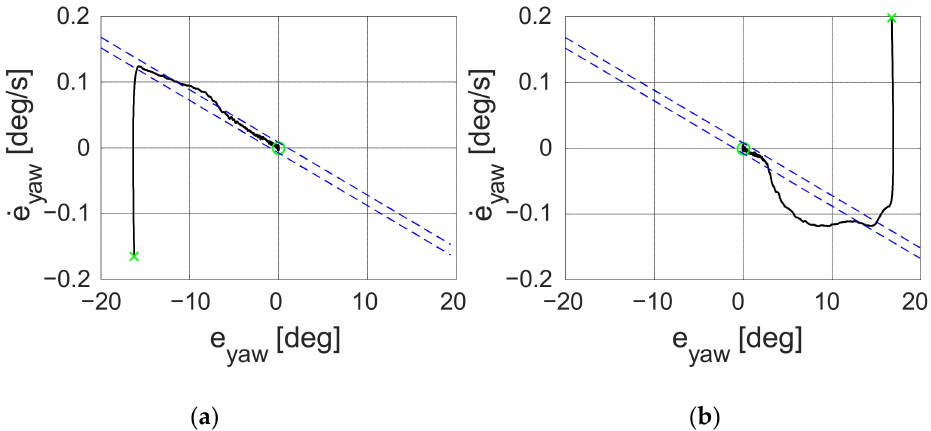
Figure 15. Yaw responses of the phase plane of the SM controller: ( a ) case 1 and ( b ) case 2 (x: initial sliding variable, o: final sliding variable, blue dotted line: boundary